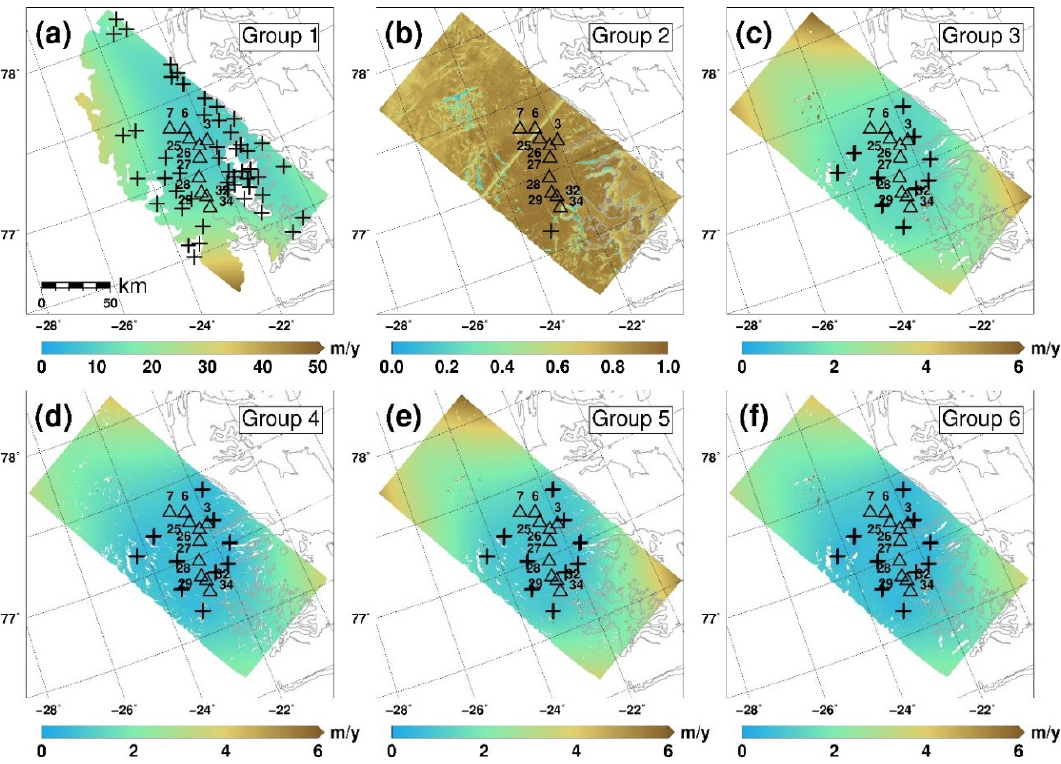
Figure 4. Task 1 quality parameters provided by groups 1 to 6 ( a – f ). For group 2 ( b ) the quality parameter is interferometric coherence, whereas for all other groups it is the predicted LoS velocity error standard deviation in m/y. Triangles represent the GPS stations used for validation. Crosses represent GCPs used for orbital refinement and absolute phase estimation.